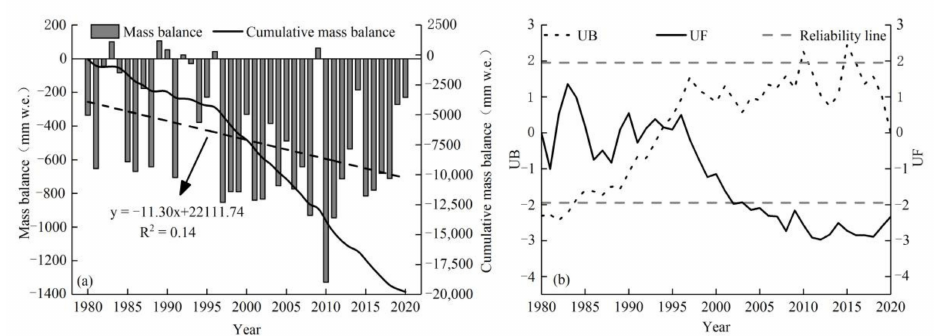
Figure 2. ( a ) Changes of mass balance of Urumqi Glacier No.1 from 1980 to 2020; ( b ) Mann-Kendall mutation test of mass balance.